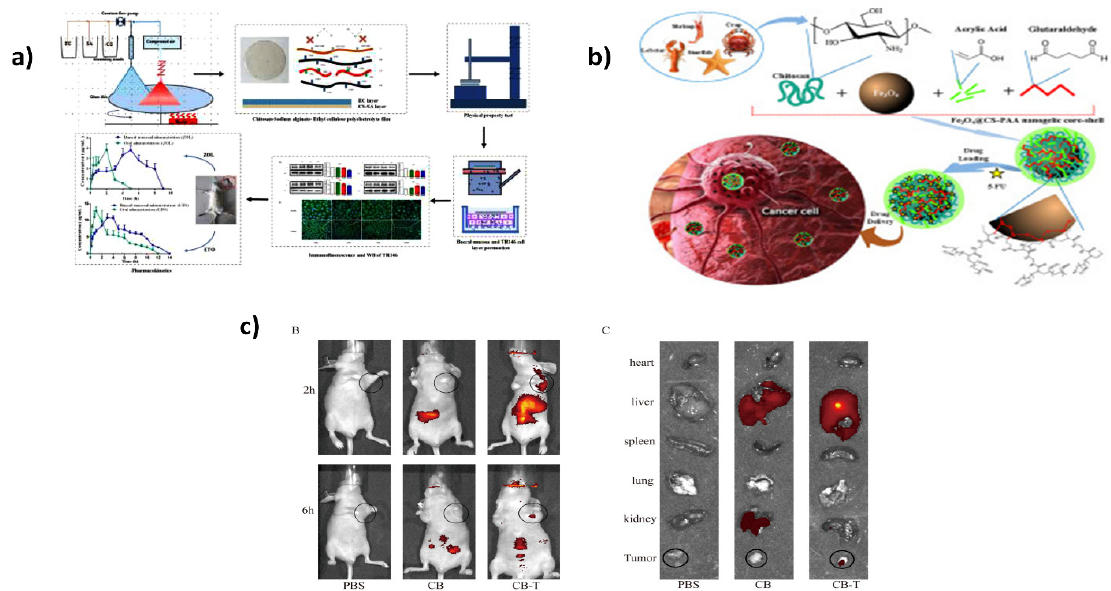
Figure 1. ( a ) Interfacial reaction solvent-drying method for EC-SA-CS polyelectrolyte film via self- made equipment [95]; ( b ) Preparation and characterization of chitosan-based magnetic